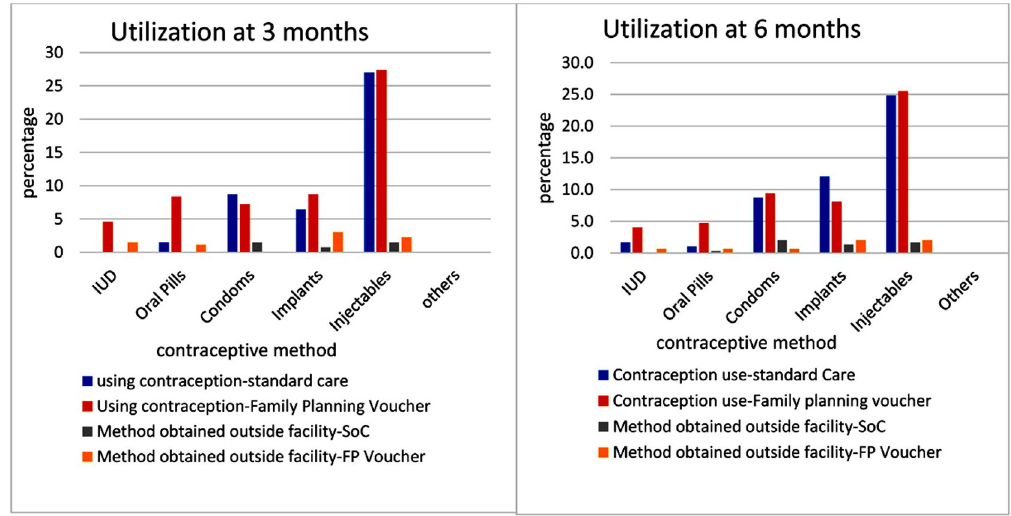
Fig 3. Percentage utilization of family planning methods at 3 months (N = 263) versus 6 months (N = 298) postpartum by study group. FP, family planning; SoC, Standard of care.